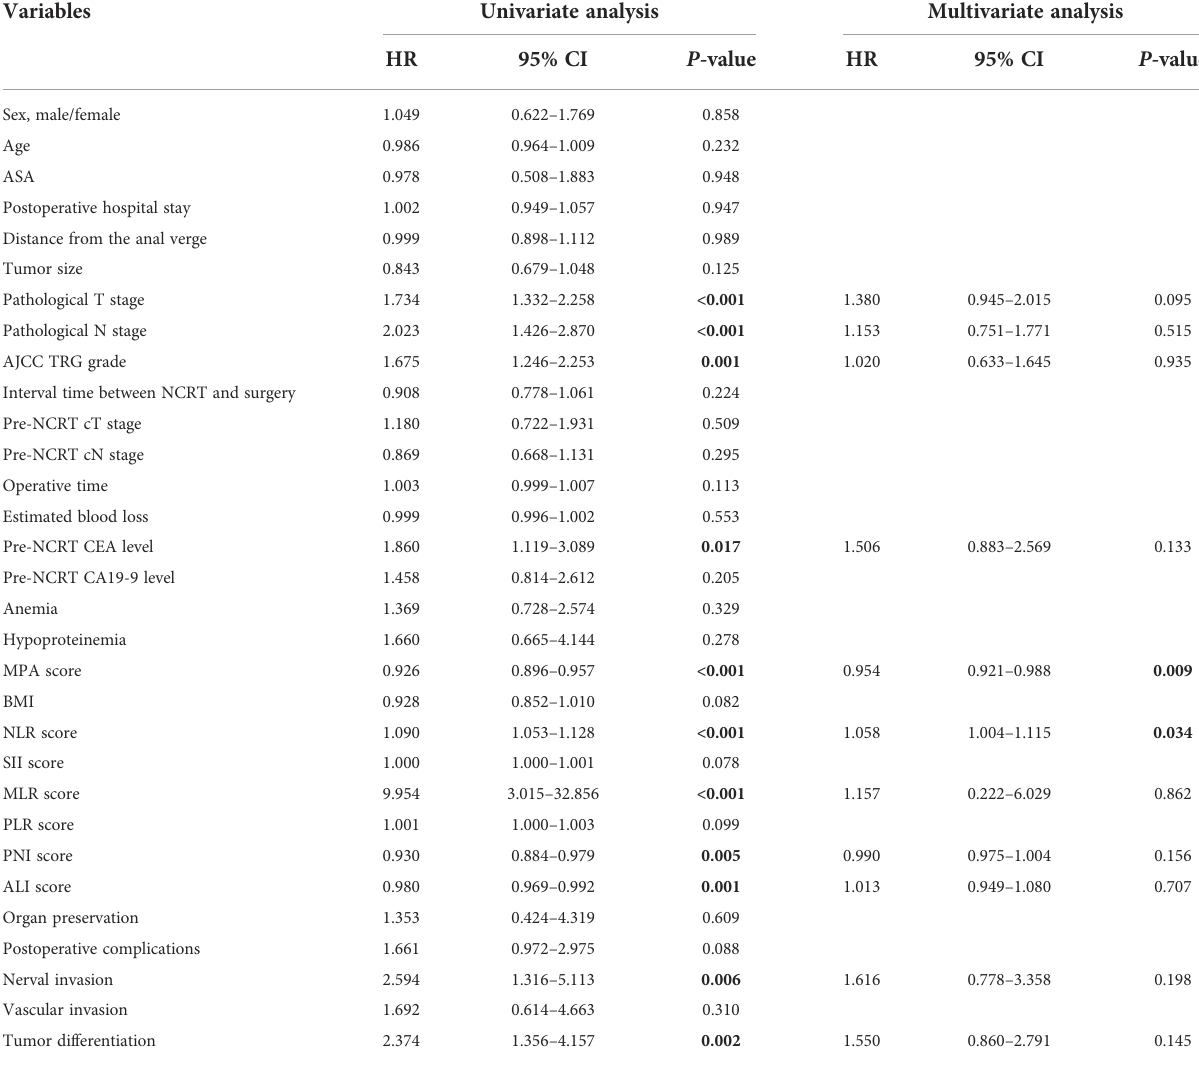
TABLE 3 Cox regression analysis of predictive factors for disease-free survival in patients with LARC after NCRT (n =